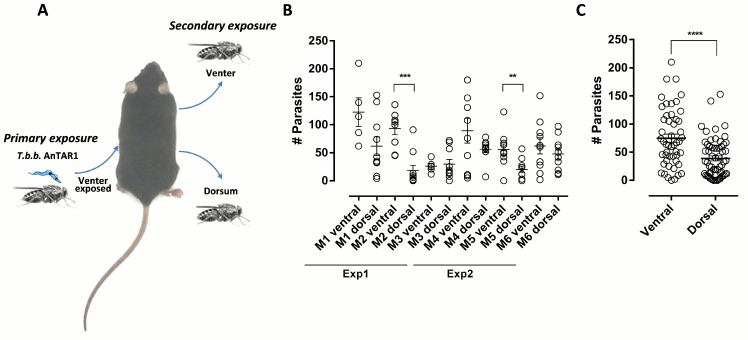
Parasite acquisition by tsetse flies from the infected dermal site.(A) Experimental setup indicating the initial infection of mice by exposure of the mouse dorsum to T.b.brucei AnTAR1 SG+ tsetse fly bites, followed 18 hpi by feeding of teneral tsetse flies on the venter or dorsum. (B) Parasites acquired during the blood feeding process were quantified by SL-RNA specific RT-qPCR on individual tsetse fly abdominal extracts (n = 5–10 fully engorged flies fed on an individual side and mouse). Data for the individual mice (M1-6) from two independent experiments with number of parasites acquired from dorsal and ventral sides. (C) Combined data of parasite numbers acquired by individual flies from the ventral (n = 50) and dorsal sides (n = 60). **: P < 0.01; ***: P < 0.001; ****: P < 0.0001